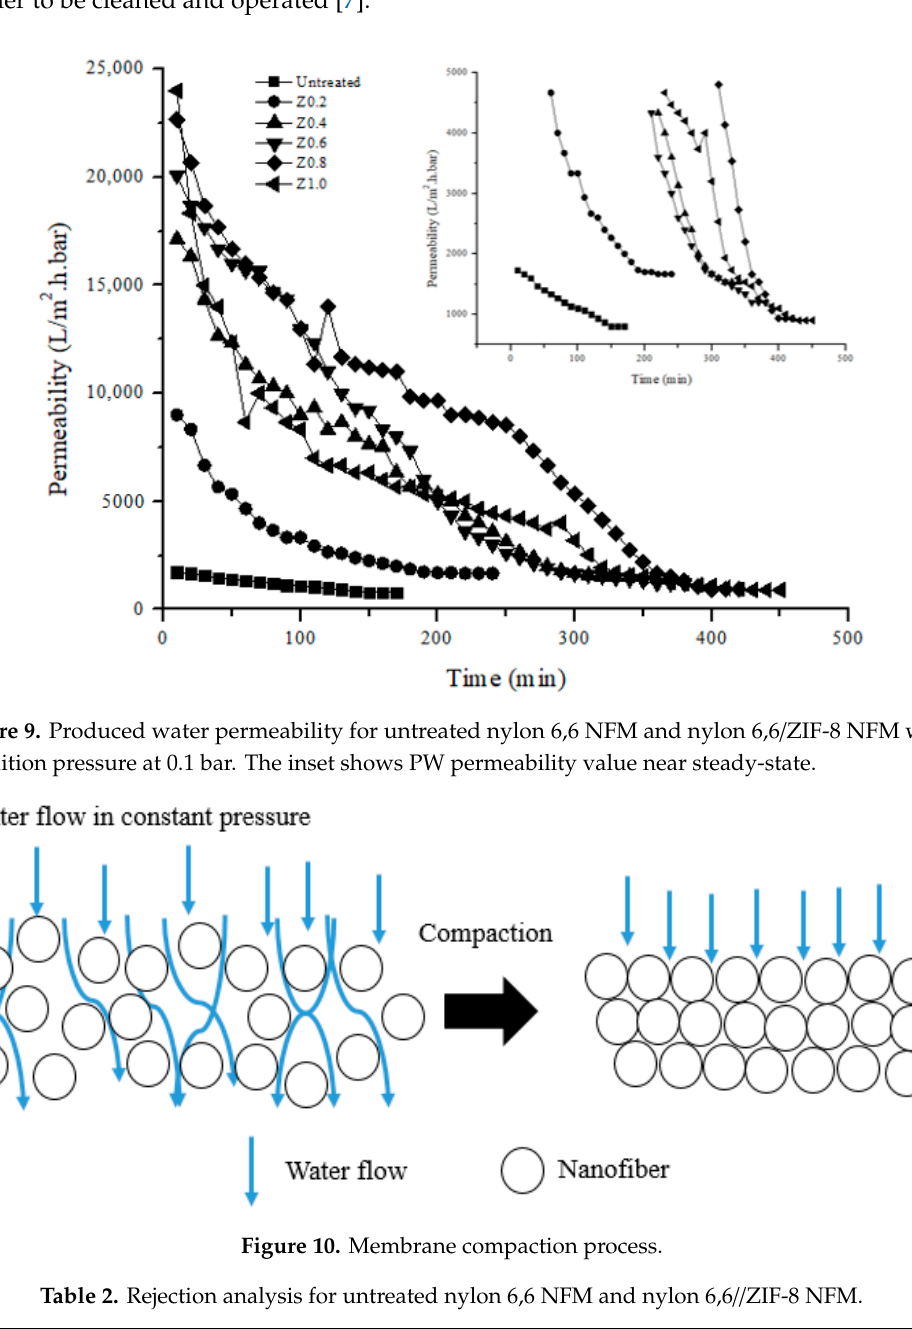
Figure 8. Pure water permeability for untreated nylon 6,6 NFM and nylon 6,6/ZIF-8 NFM with condition pressure at 0.1 bar. The inset shows water permeability value near steady-state.